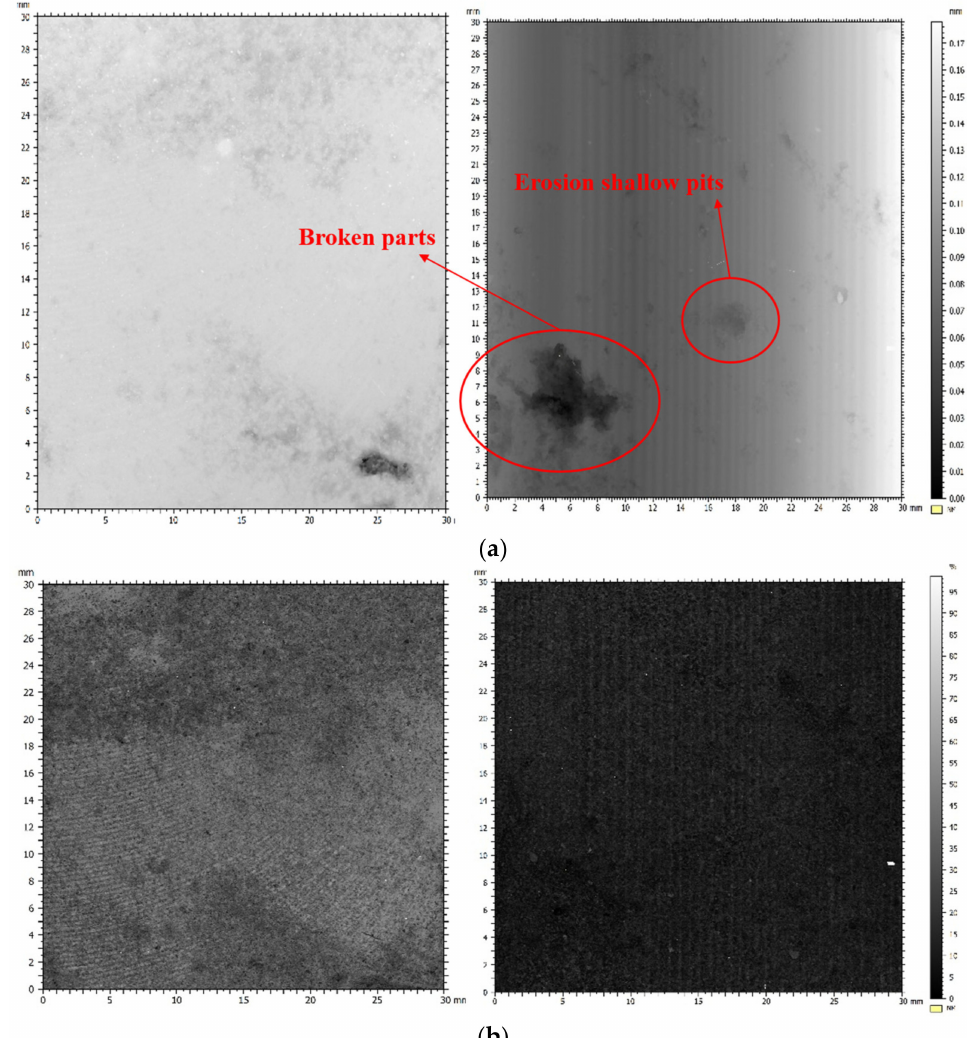
Figure 10. The scanning results of the three-dimensional appearance instrument before and after the experiment should be listed as follows: ( a ) the surface height scanning results before and after washing ( left : before experiment; right : after experiment); ( b ) the surface intensity scanning results before and after washing ( left : before experiment; right : after